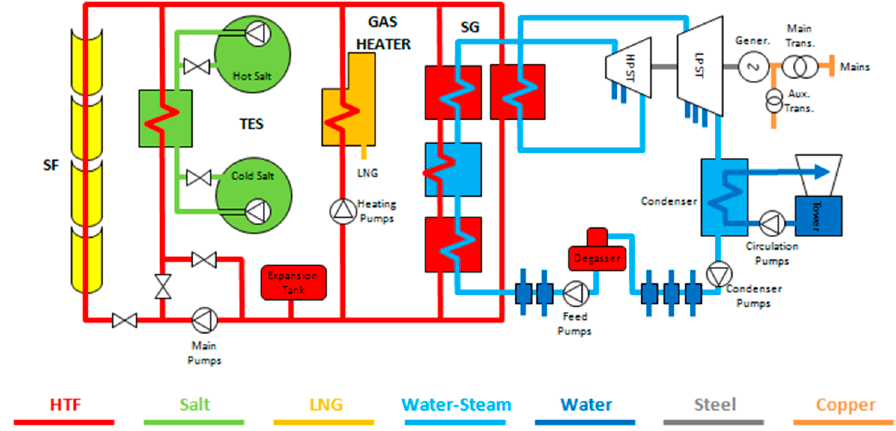
Figure 3. Schematic of a solar thermal power plant.